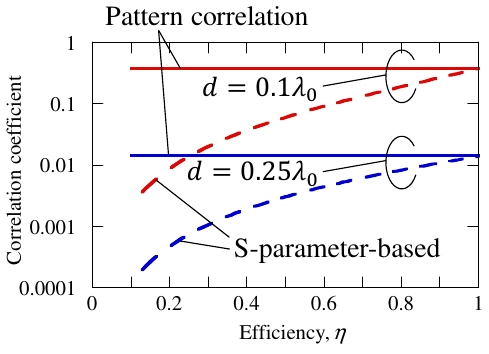
Figure 13. Lossy dipole array model ( M = 2).